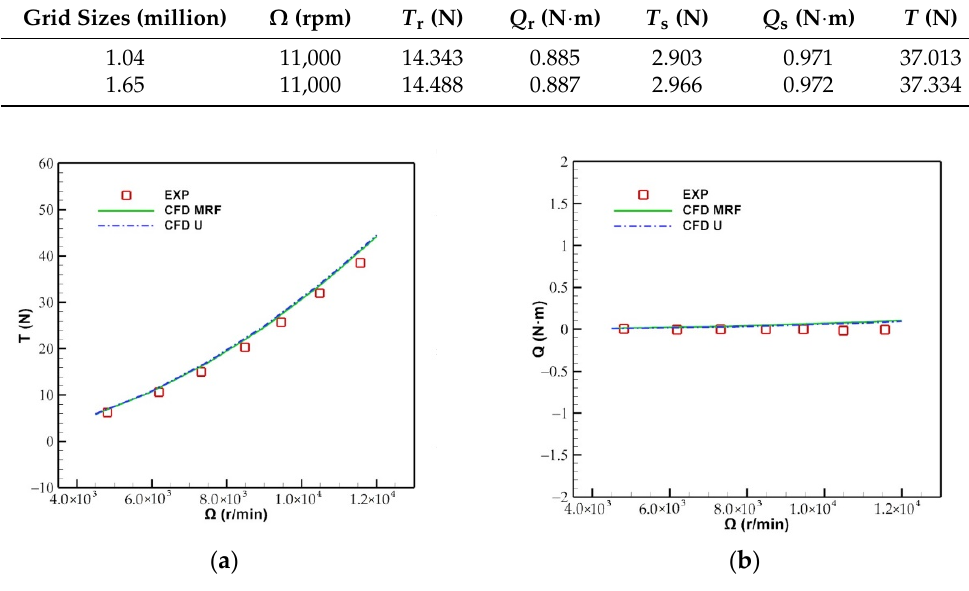
Figure 6. Comparison of the results between the experiment and CFD methods: ( a ) Total thrust, ( b ) total torque.